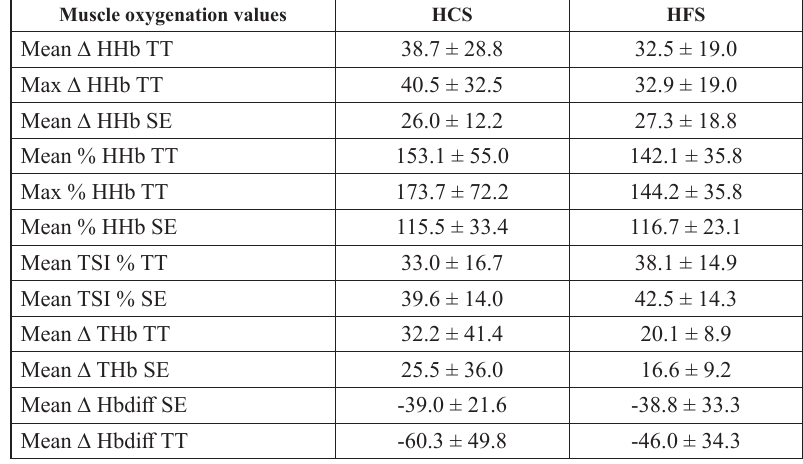
Table 4. Muscle oxygenation values during the cycling